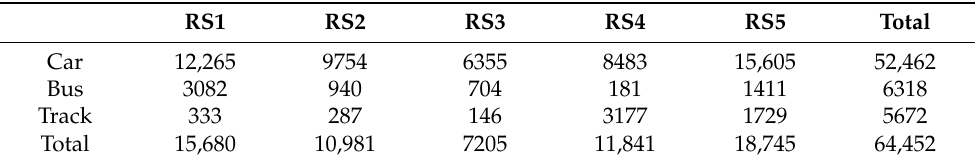
Table 2. Statistical results of the three types of vehicles in the collected datasets. RS represents the different road intersections.